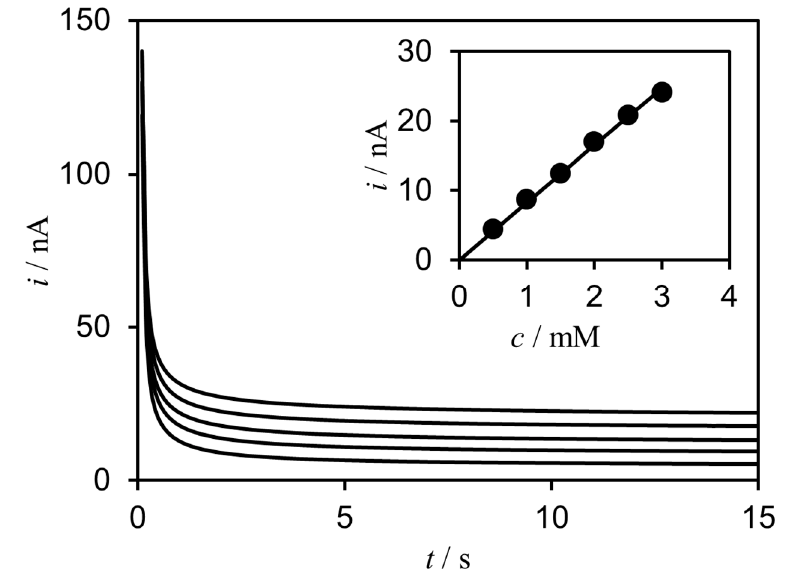
Figure 5. Chronoamperometric response for glucose oxidation in a buffer solution containing 0.21-mM FAD-dependent glucose dehydrogenase (FAD-GDH) and 1-mM 1,2-benzoquinone at a microelectrode with diameter of 50 µ m. Inset shows the calibration curve based on the current at 10 s. Reprinted with permission from ref. [39], Copyright (2013) Japan Society for Analytical Chemistry.